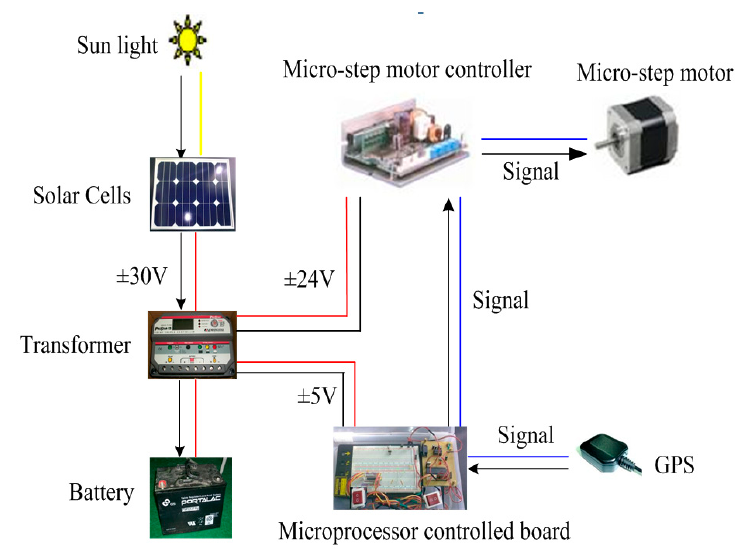
Figure 2. The solar tracking system block diagram.